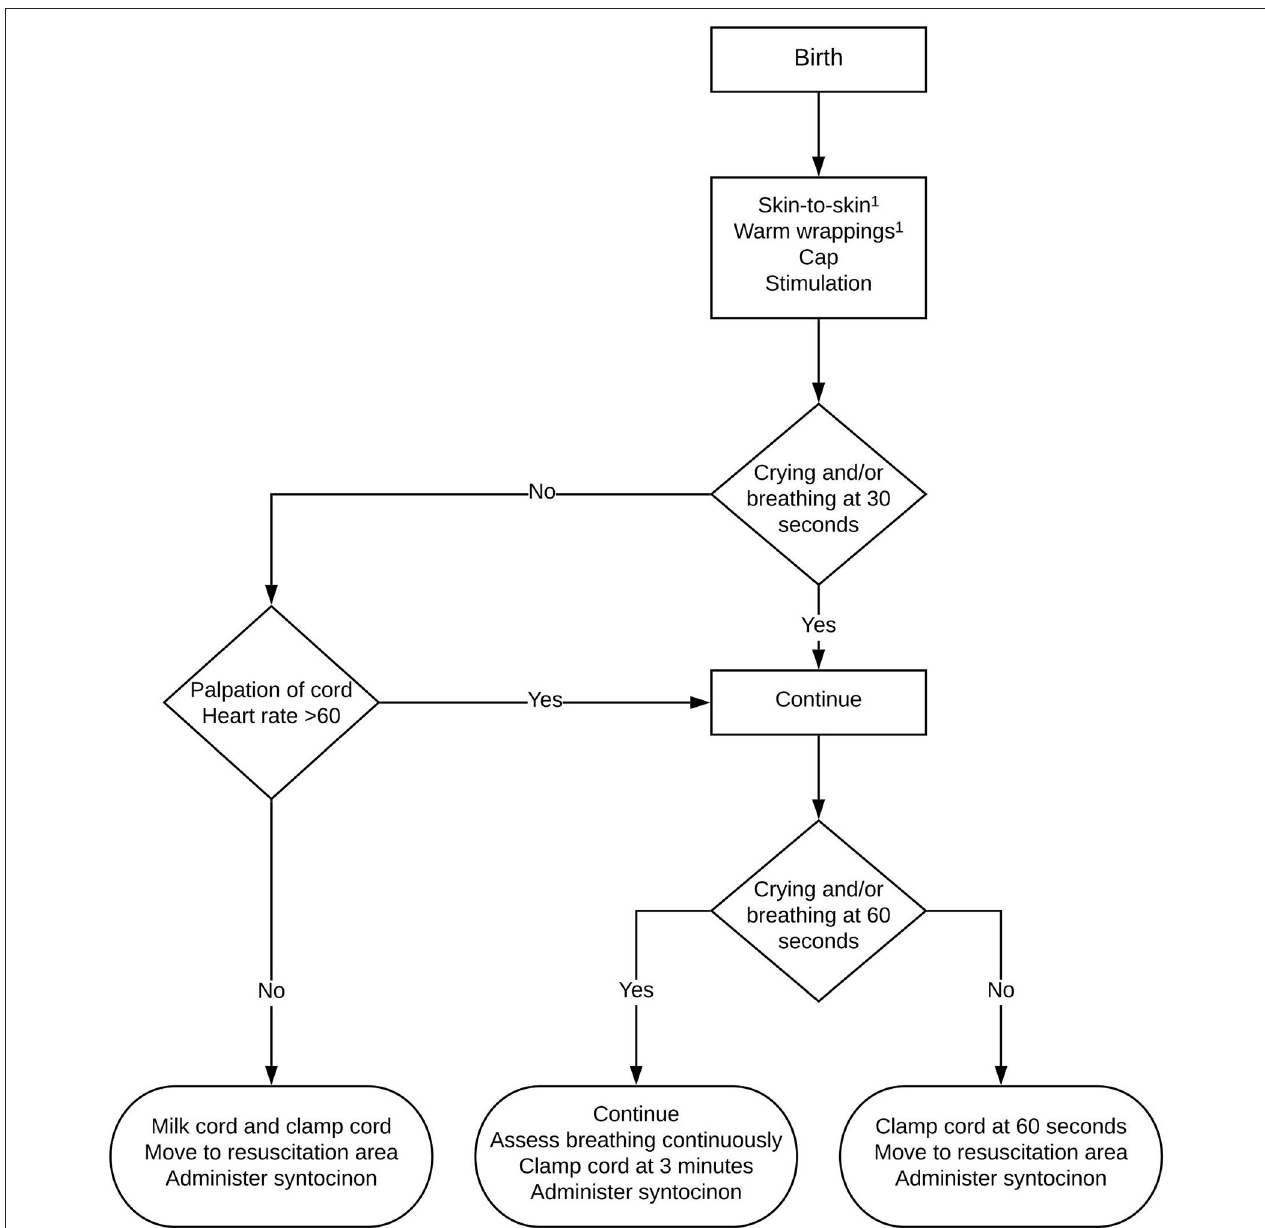
FIGURE 1 | Flowchart of delayed cord clamping protocol at Erasmus MC, The Netherlands. 1 During caesarean section: first dry, then stimulate. After cord clamping: skin-to-skin with warm wrappings or move to resuscitation area.